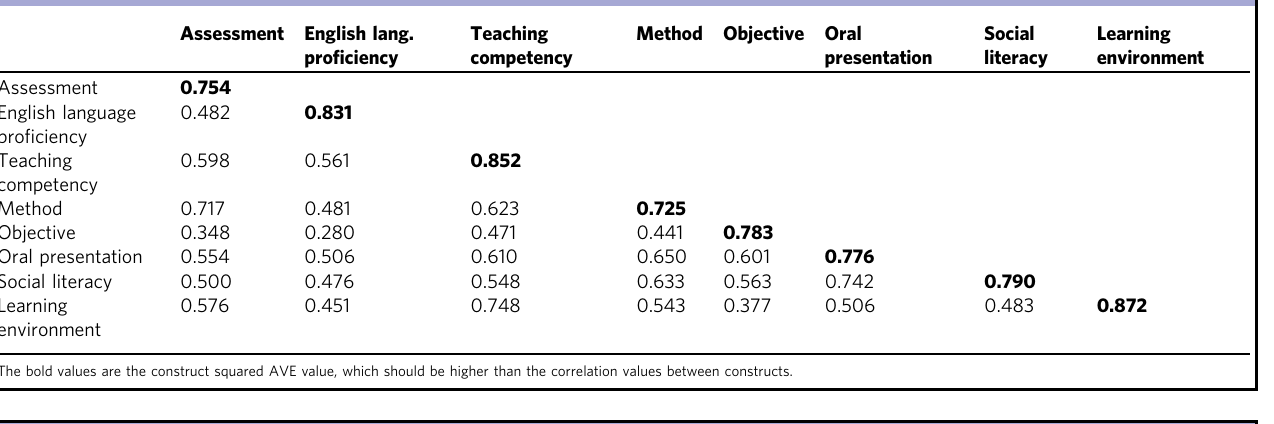
Table 5 The Fornell and Larcker ’ s (1981) criterion analysis for the initial measurement model.